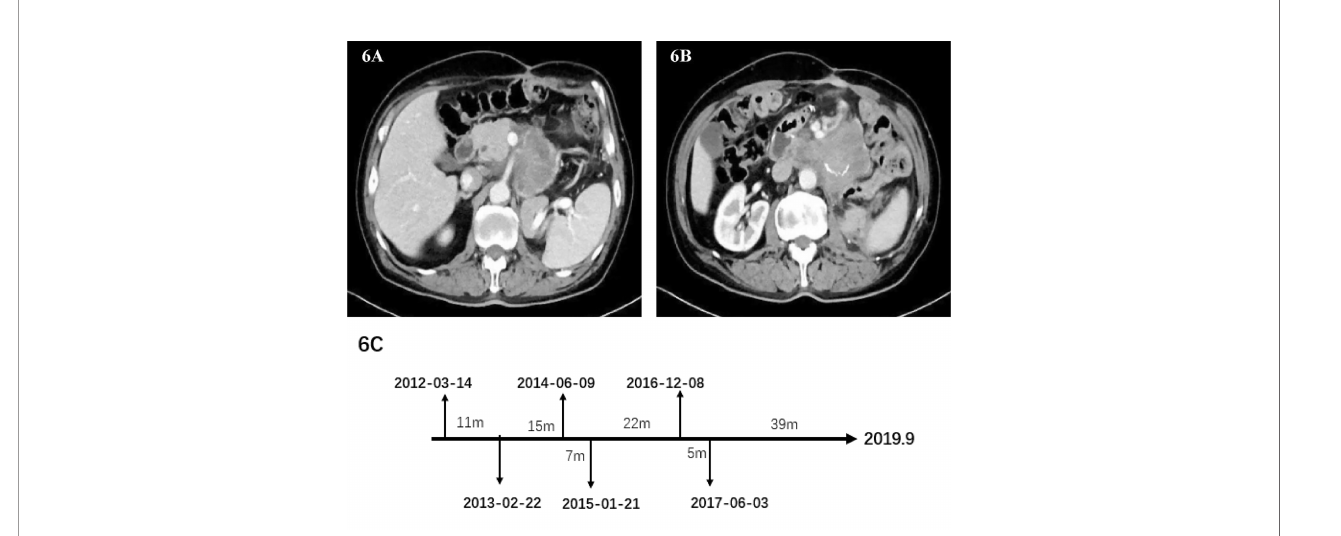
FIGURE 6 | (A, B) Abdominal image before the sixth operation. (C) Date chart of